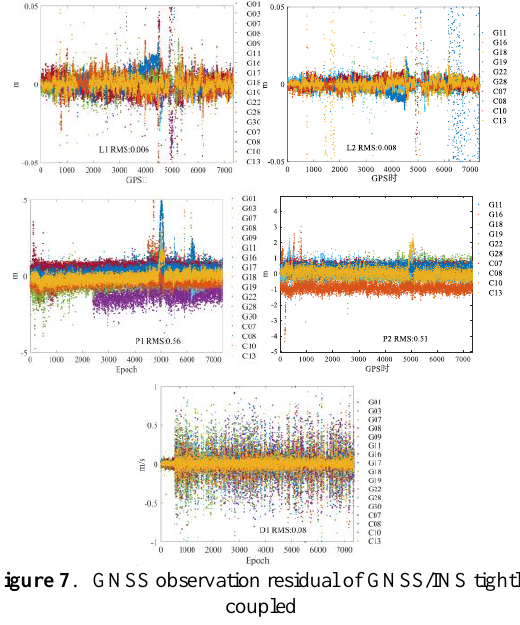
Figure 5 . Velocity error of GNSS/INS tightly-coupled in END direction